Question: Describe this figure in one sentence.
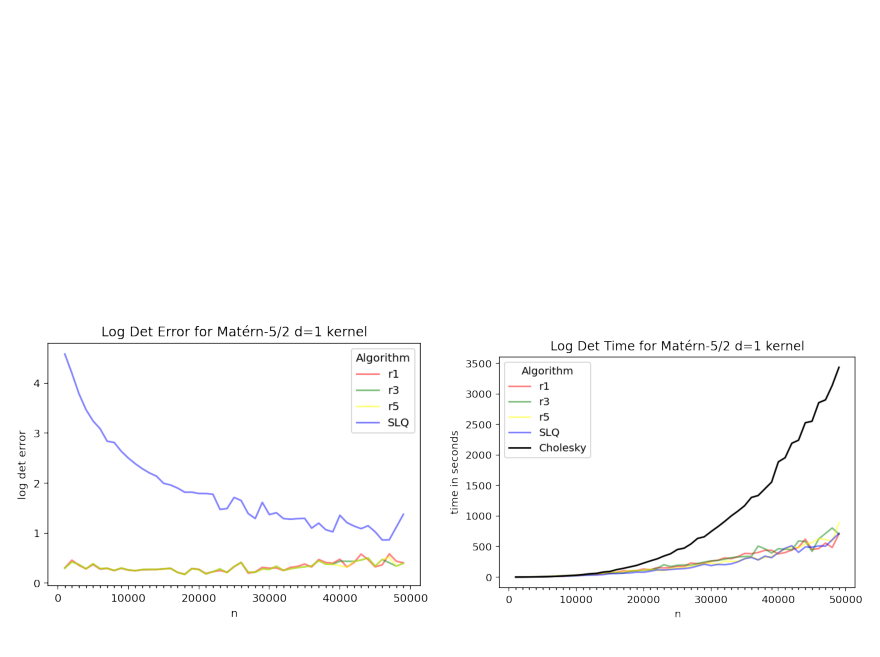
Answer: Comparison of log det algorithms as a function of n on the Mat´ern-5/2 kernel with d = 1 as measured on an Intel CPU. All measurements are averages over 100 randomly generated kernels.